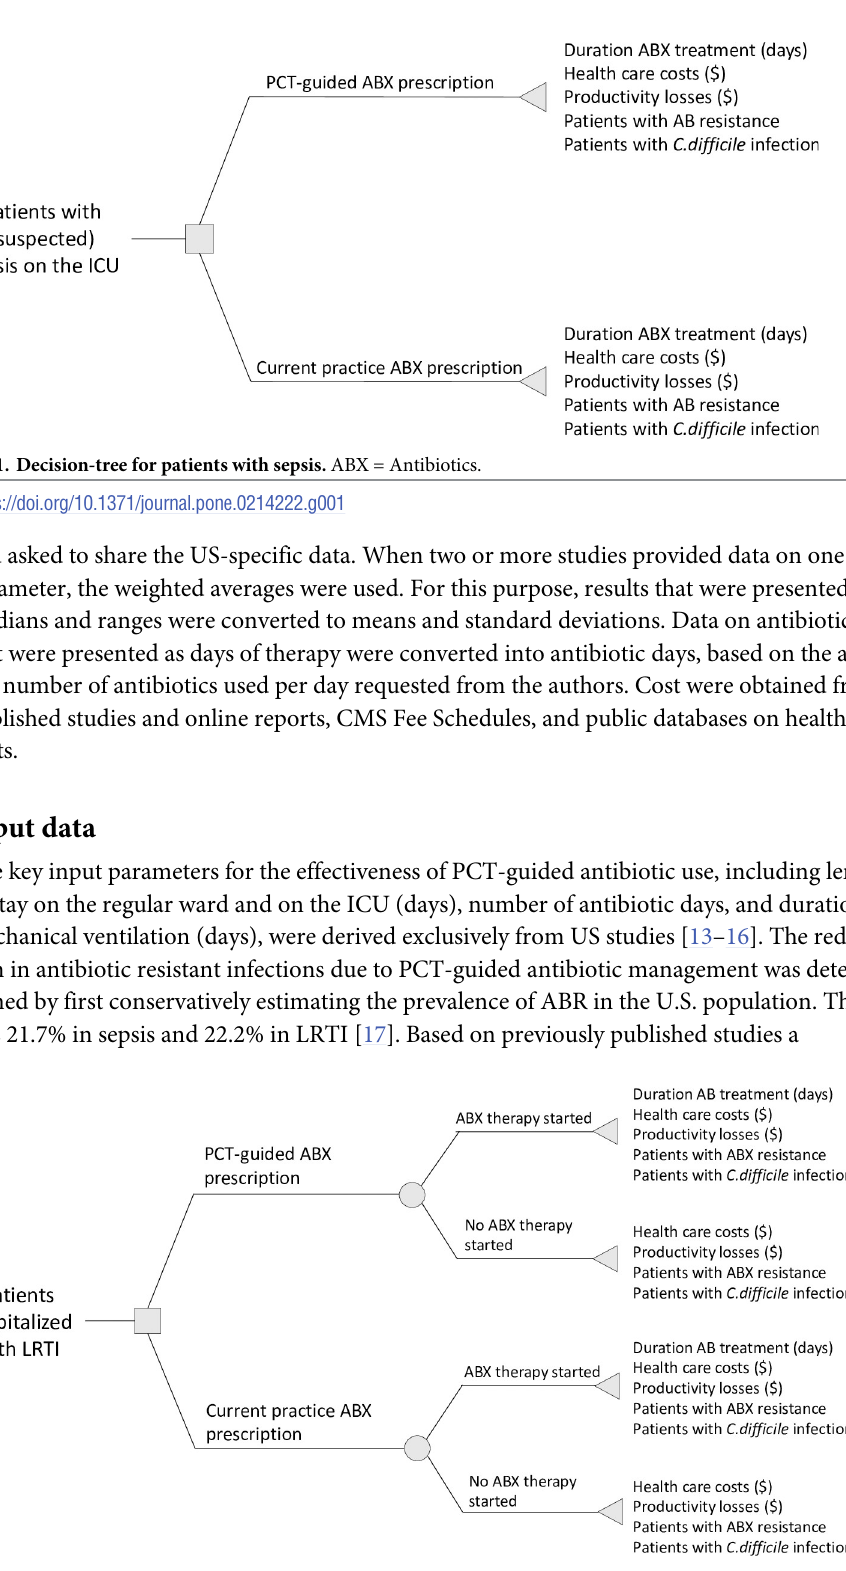
Fig 2. Decision-tree for patients with LRTI. ABX =